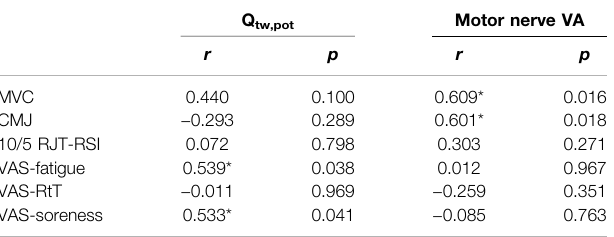
TABLE 4 | Pearson product-moment correlation coef fi cients between neuromuscular variables and physical function and perceptual measures (% changes from pre-to 24 h post-exercise). Q